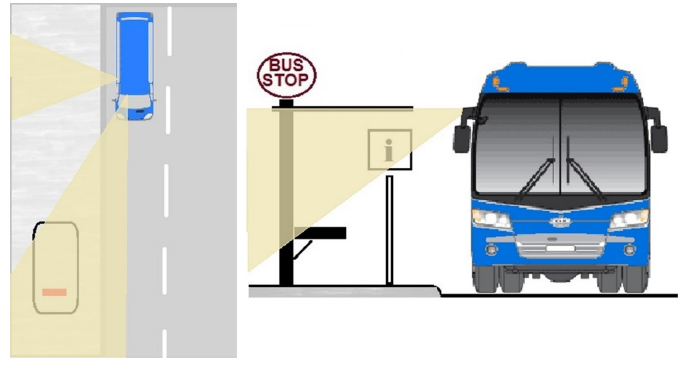
Figure 8. External vehicle sensors.